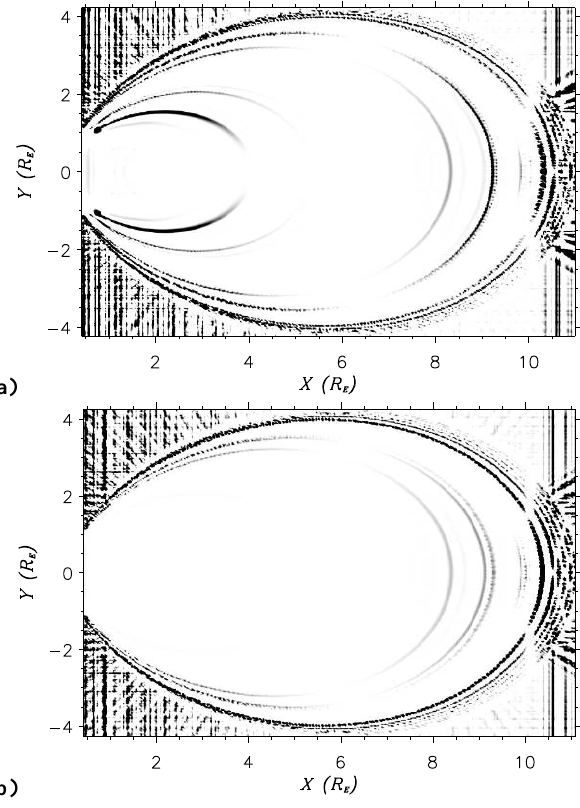
Fig. 8. The distribution of the amplitude | B y (x 1 ) | of the same oscillations as in Fig. 7, in the meridional plane. The darker colour marks the regions with high oscillation